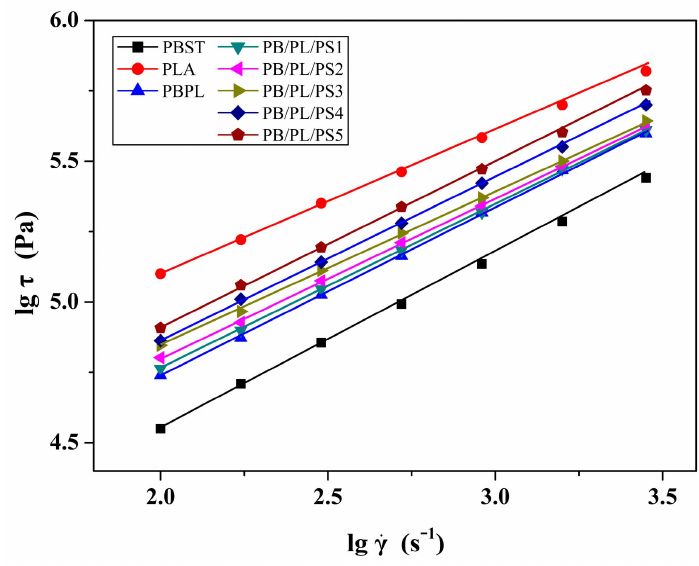
. γ of samples under 190 ◦